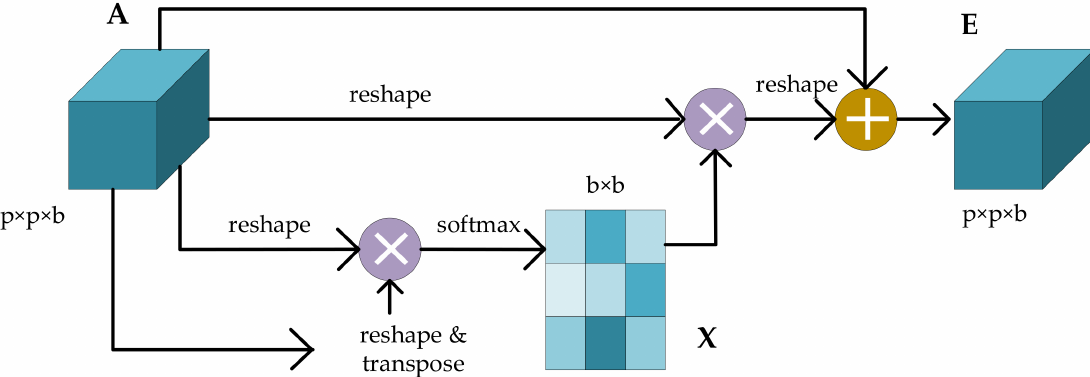
Figure 2. The schematic diagram of the spectral attention